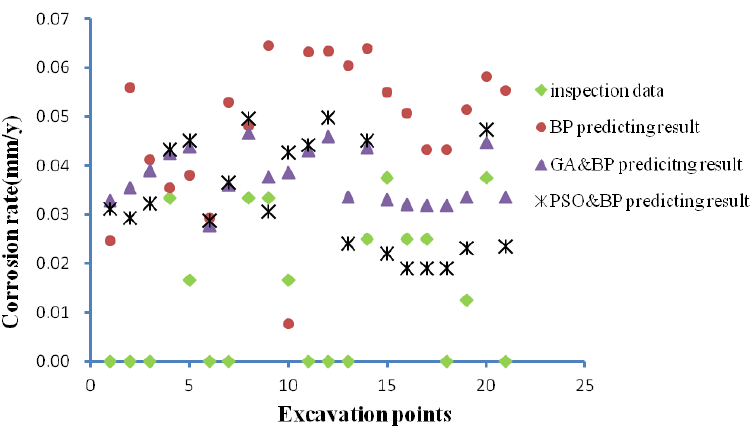
Figure 4. The predicted results of the BP, GA and BP, and PSO and BP